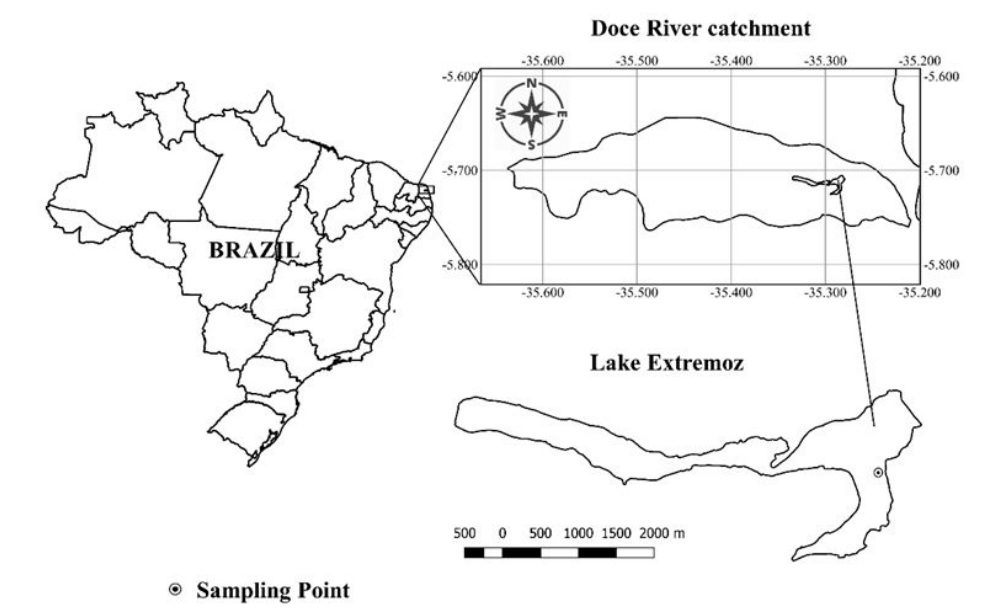
Figure 1. Location of the Lake Extremoz in the northeast of